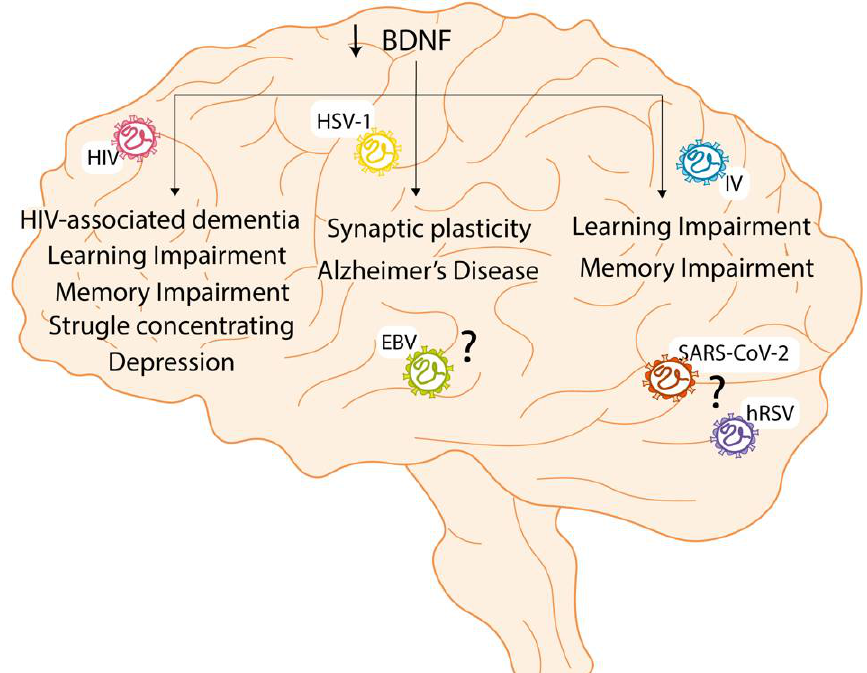
Figure 3. Neurological sequels in the long term due to the viral infection decreasing BDNF levels. The human immunodeficiency virus (HIV) can decrease BDNF levels and cause HIV-associated dementia (HAD), learning and memory impairment, struggle concentrating, and depression. The influenza virus (IV) can decrease BDNF levels and cause learning and memory impairment. In the case of human respiratory syncytial virus (hRSV) and severe acute respiratory syndrome, coronavirus 2 (SARS-CoV-2) are both respiratory viruses associated with learning and memory impairment, suggesting that the decrease in the levels of BDNF causes these impairments. Lastly, herpes simplex virus-1 (HSV-1) can decrease BDNF levels and cause synaptic plasticity and Alzheimer’s disease. Because Epstein Barr virus (EBV) belongs to the Herpesviridae, it can be suggested that it might decrease BDNF levels and cause these pathologies.